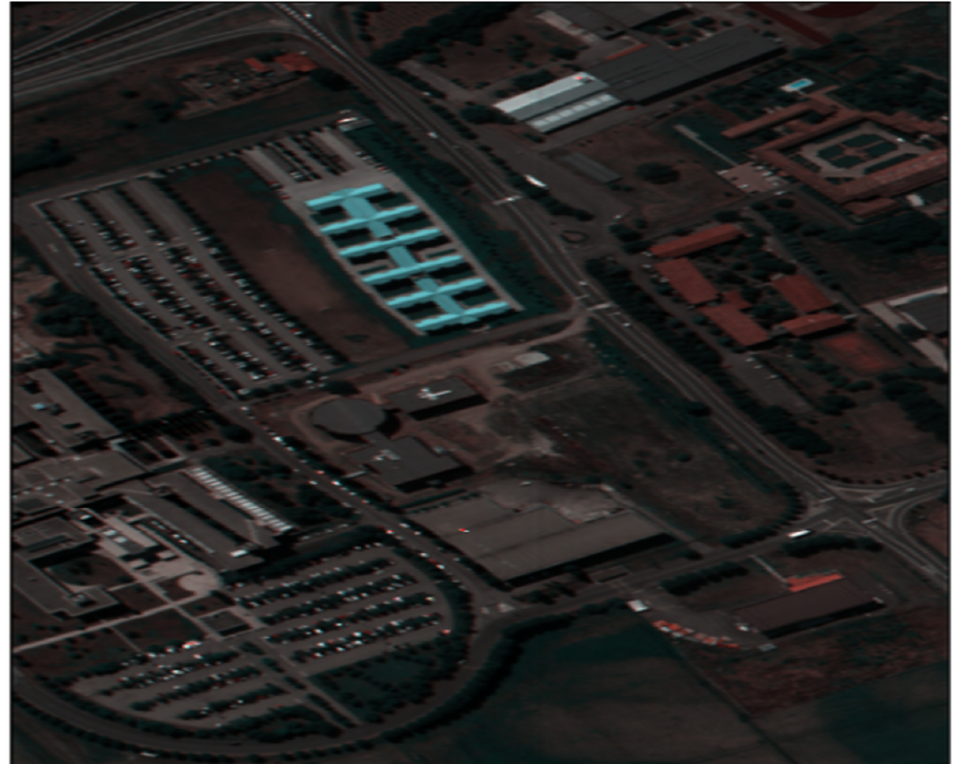
Figure 8. Pavia Dataset Image Segmentation.